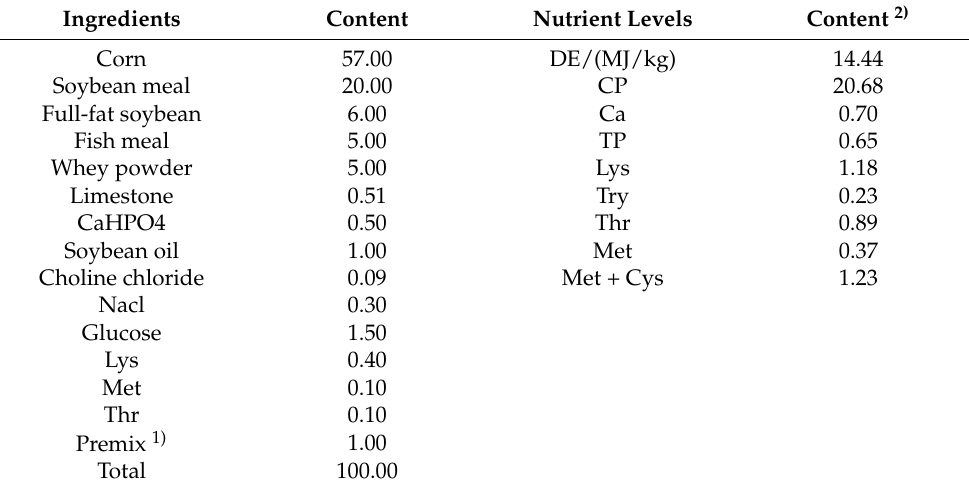
Table 1. Composition and nutrient levels of the basal diet (air-dry